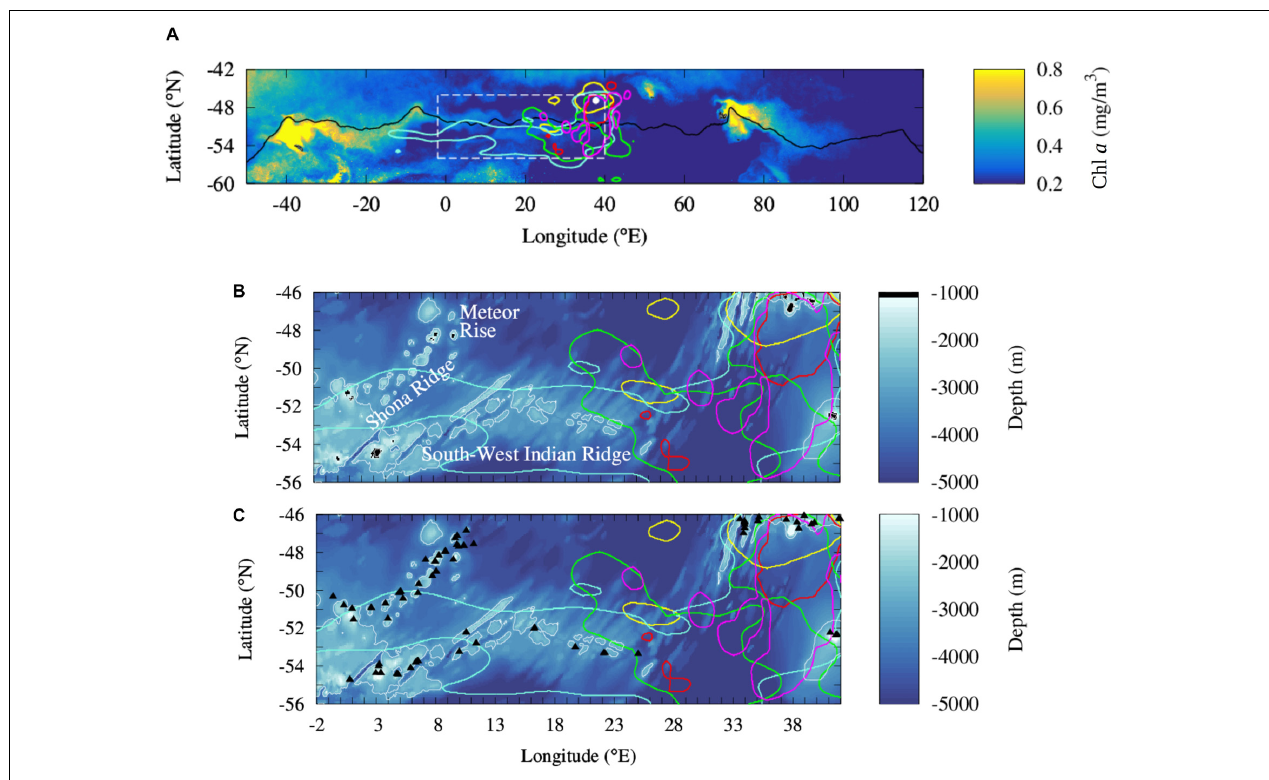
FIGURE 1 | Comparison of the at-sea distribution of five species of predators from the Prince Edward Islands to the distribution of regional phytoplankton biomass and shallow topographies in the southern Agulhas Basin. (A) Large scale climatology of concentration in chlorophyll a in the Atlantic and Indian sectors of the Southern Ocean during the bloom period (from November to January) between 2000 and 2015. Intense chlorophyll a blooms spread downstream of South Georgia (36 ◦ W; 54 ◦ S) and Kerguelen Plateau (70 ◦ E; 49 ◦ S) transported by the ACC. The solid black line locates an intense ACC core, the Polar Front. Dashed white box locates the study region shown in the bottom panels. (B,C) Comparison of shallow topography ( < 1000 m depth) identified in a global bathymetric product ( B , black areas) and seamounts shallower of 1000 m located by Yesson et al. (2011) ( C , black triangles) in the southern Agulhas Basin. Colored contour lines locate the at-sea habitat of Antarctic Fur Seals ( Arctocephalus gazella ; red), Southern Elephants Seals ( Mirounga leonina ; yellow), King Penguins ( Aptenodytes patagonicus ; cyan), Macaroni Penguins ( Eudyptes chrysolophus ; green) and Southern Rockhopper Penguins ( Eudyptes chrysocome chrysocome ; magenta) from the Prince Edward Islands (white dot in the A ) [data are reproduced from Reisinger et al.